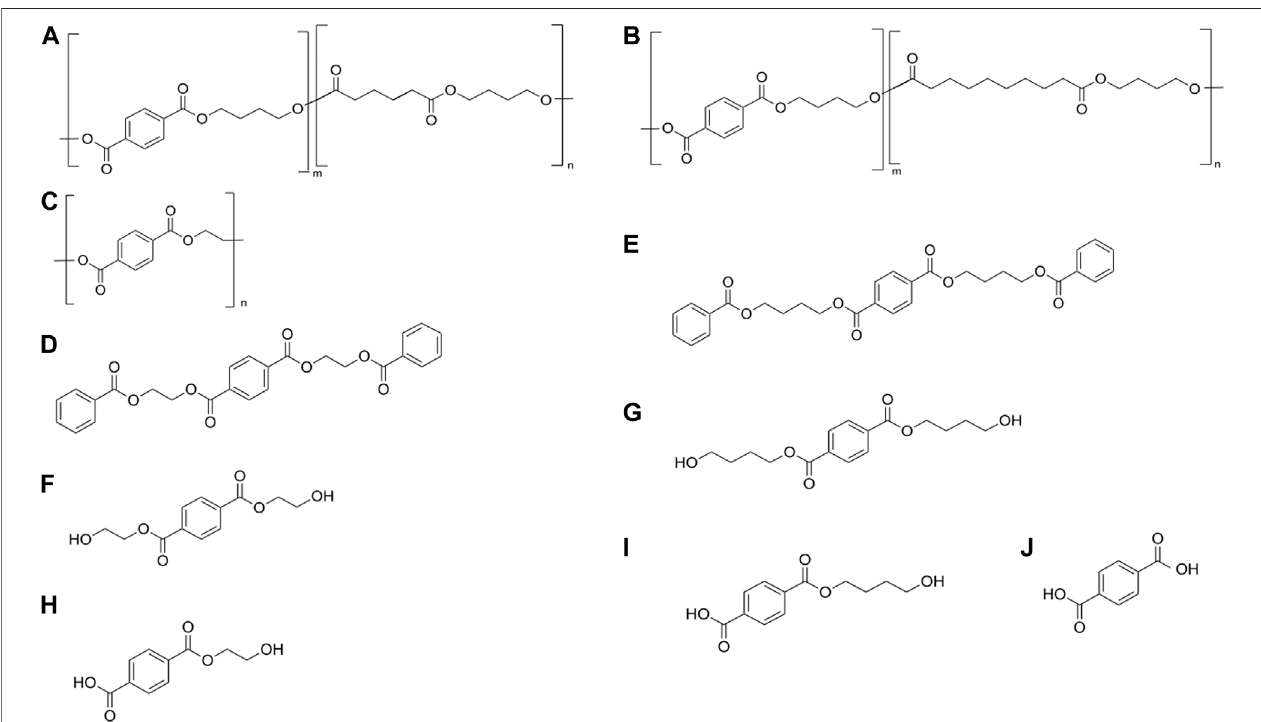
FIGURE 1 | Substrates and degradation products of Ples. (A) PBAT, (B) PBSeT, (C) PET, (D) 3-PET, (E) 3-PBT, (F) BHET, (G) BHBT, (H) MHET, (I) BT, (J) T. ecovio ® FT is a blend of (A,B) , with a small amount of added polylactic acid (less than 10%).